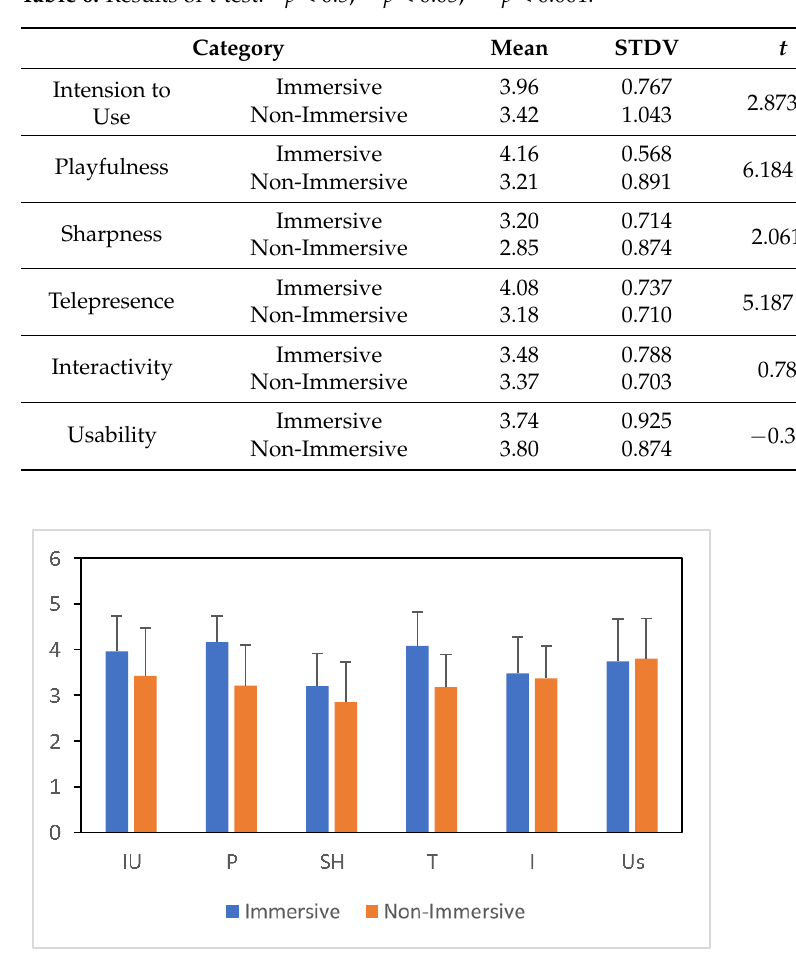
Table 6. Results of t-test. * p < 0.5; ** p < 0.05; *** p < 0.001.